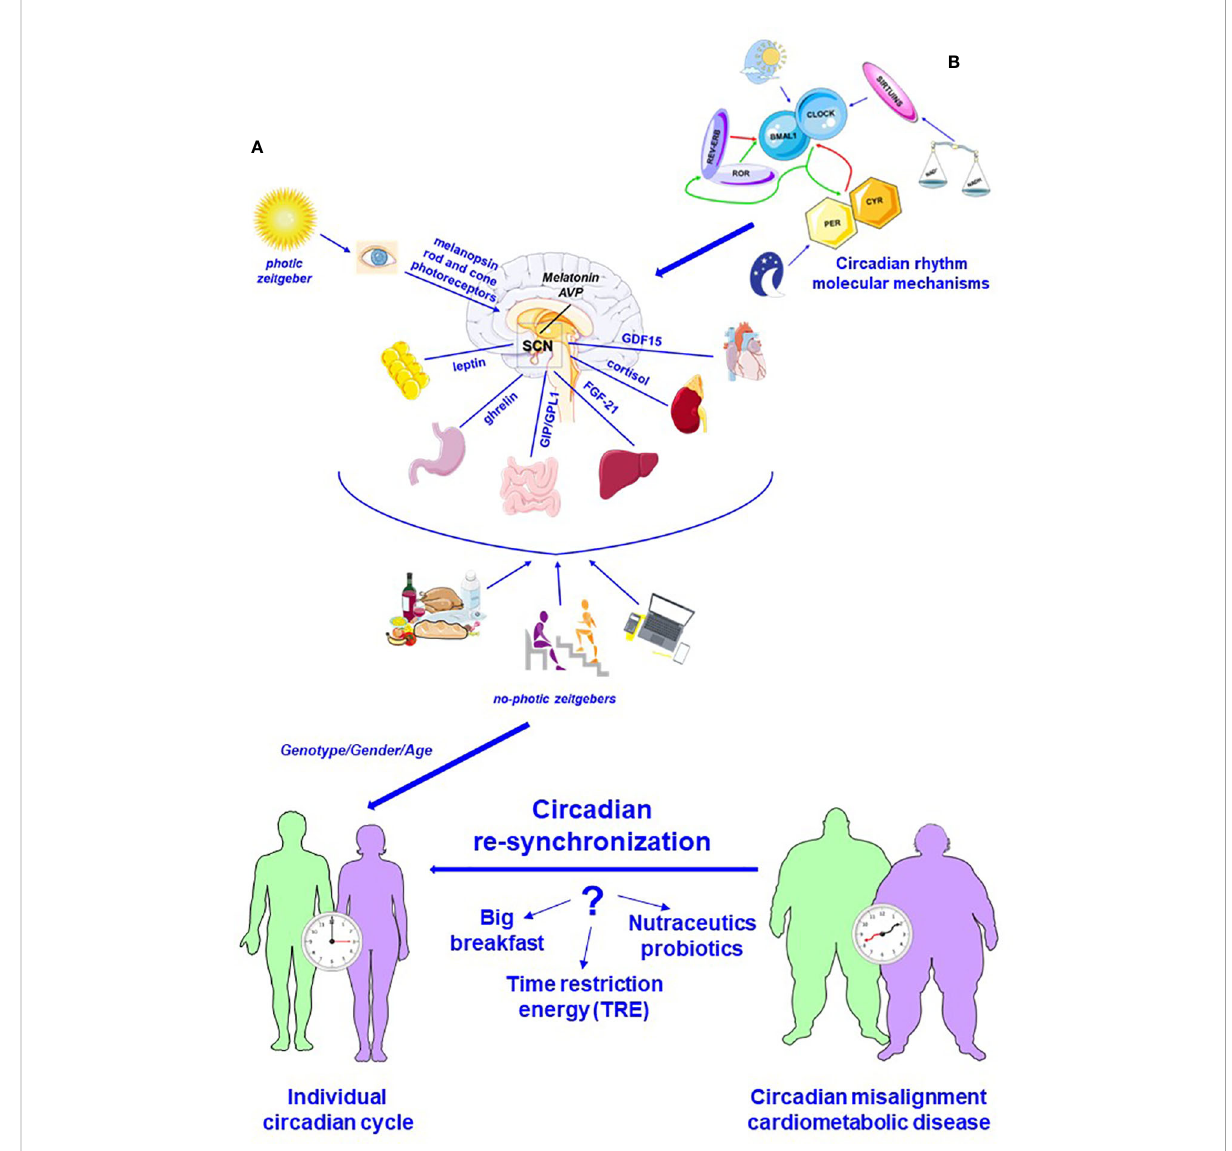
FIGURE 1 Schematic representation of the circadian system. (A) Circadian system is a complex communication network that allows to combine different signaling, photic and no-photic zeitgebers, maximizing the use of resources and safeguarding the survival. Light, converted into a neural